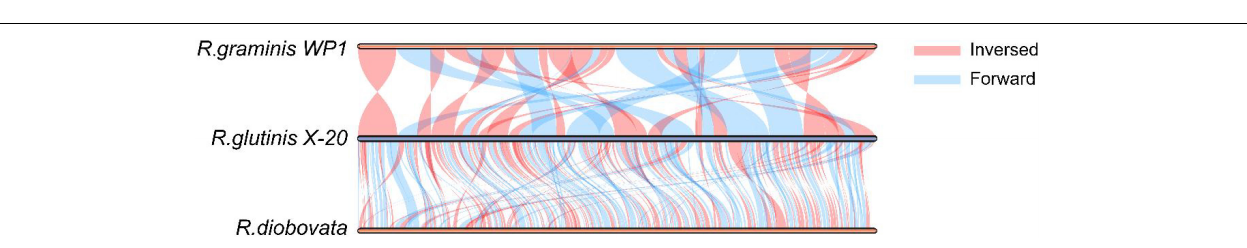
FIGURE 3 | Analysis of the genome collinearity blocks between R. glutinis X-20 genes with its two close related species. MCScanX was used to conduct pair-wise alignments of R. glutinis X-20, R. graminis WP1, and R. diobovata complete genome sequences. In three genomes, blue lines represent Forward collinear blocks and pink bars represent Inversed collinear